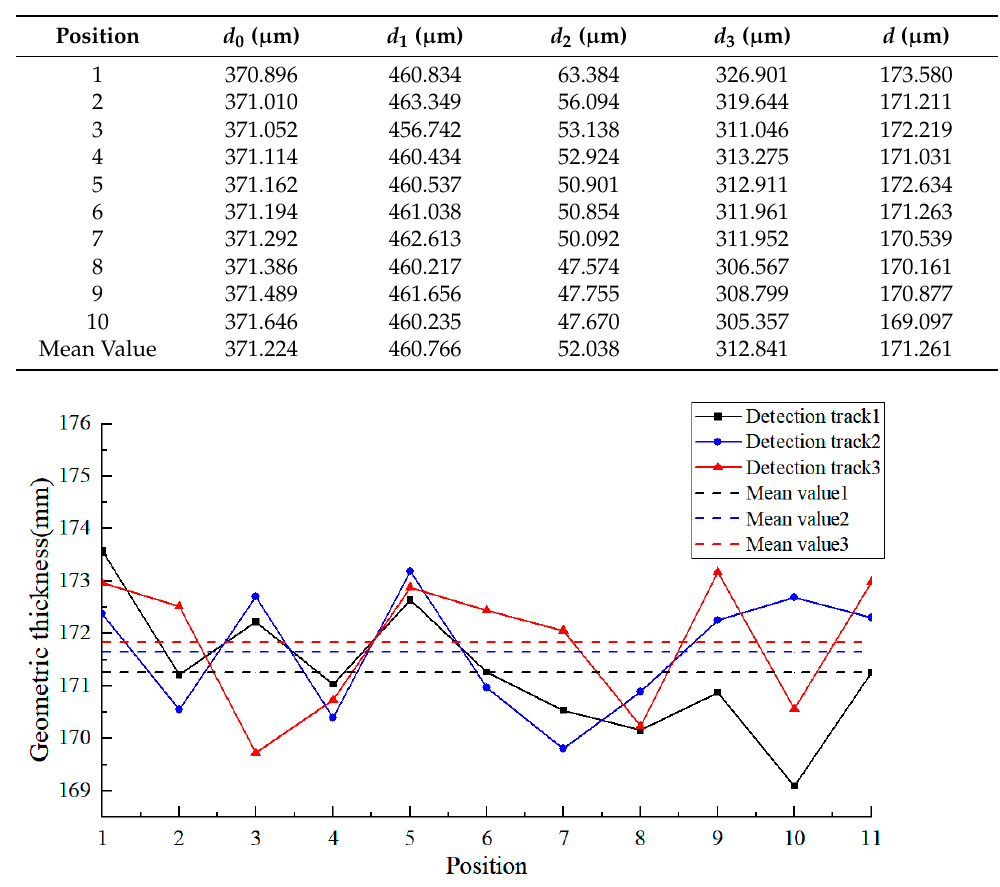
Table 1. The results of different positions in detection track 1.